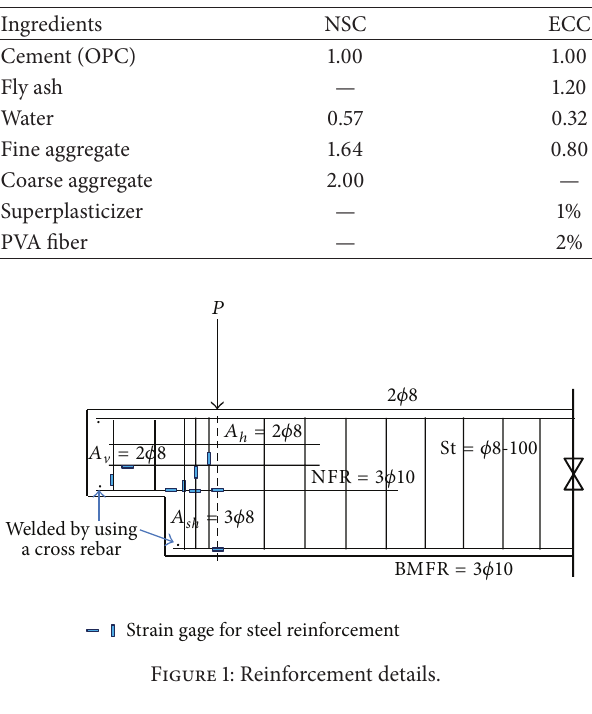
Table 1: Mix proportions.